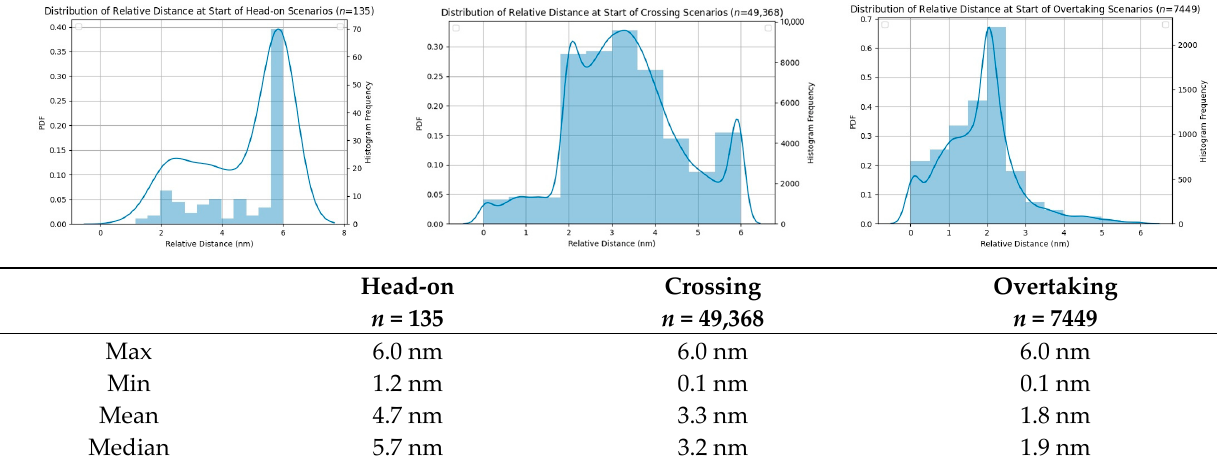
Figure 6. Distribution of relative distance at the start of different encounter scenarios. The numbers indicate how far away two ships are when the encounter situation is being initiated. Figure 7 indicates the distribution of RS at the start of different encounter scenarios.